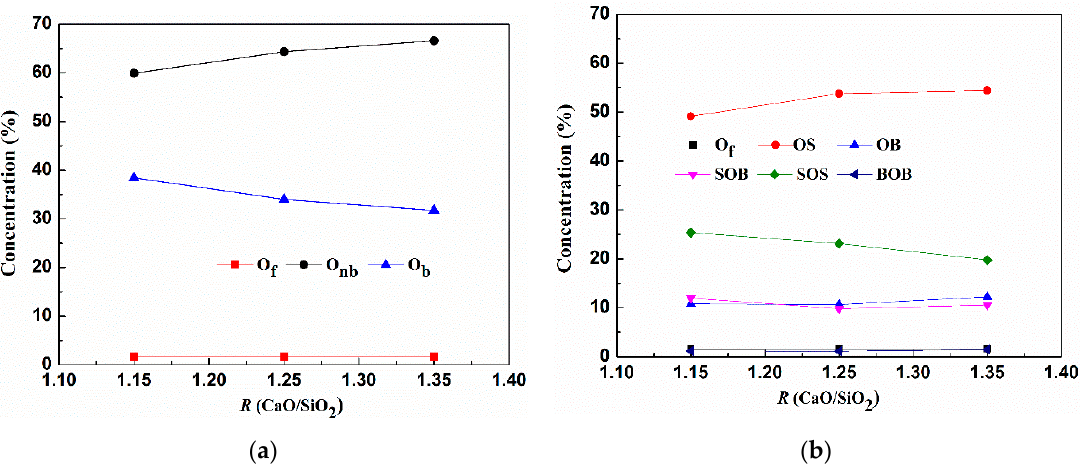
Figure 2. ( a , b ) Effect of basicity on different types of oxygen distribution in CaO-SiO 2 -B 2 O 3 system.